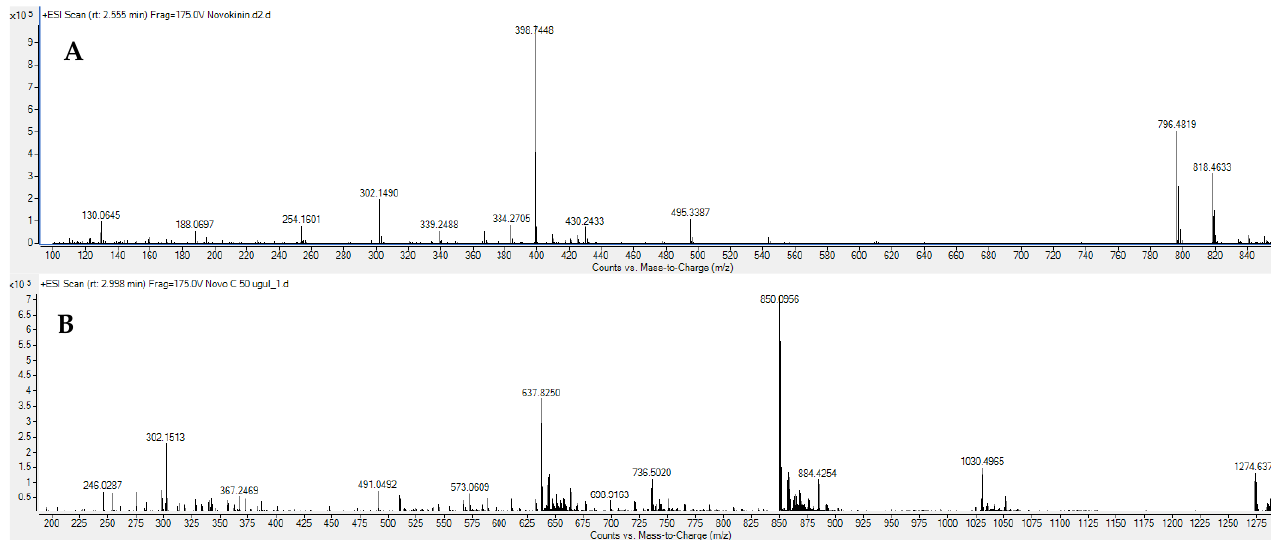
Figure 1. Extracted ion chromatogram (EIC) of ( A ) novokinin and ( B ) Novo Conj through LC/Q-TOF.